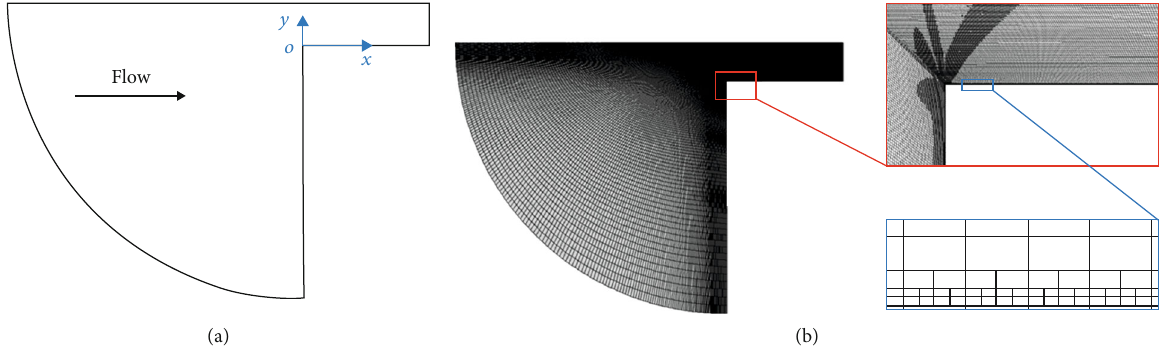
Figure 3: Computational domain and the typical mesh applied: (a) simpli fi ed 2-D computational domain and (b) mesh for the simpli fi ed 2-D gap.